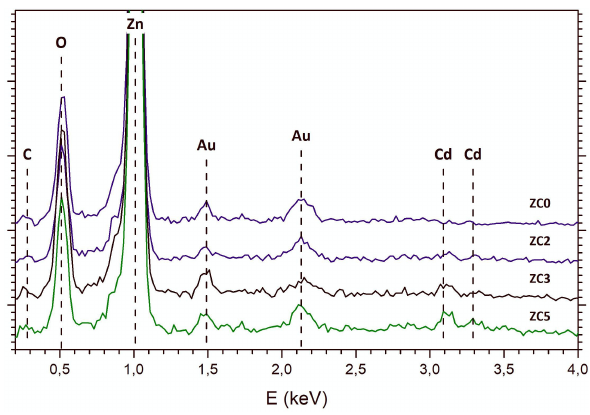
Figure 8: EDS spectra for undoped sample and samples doped with 2, 3 and 5% of cadmium.